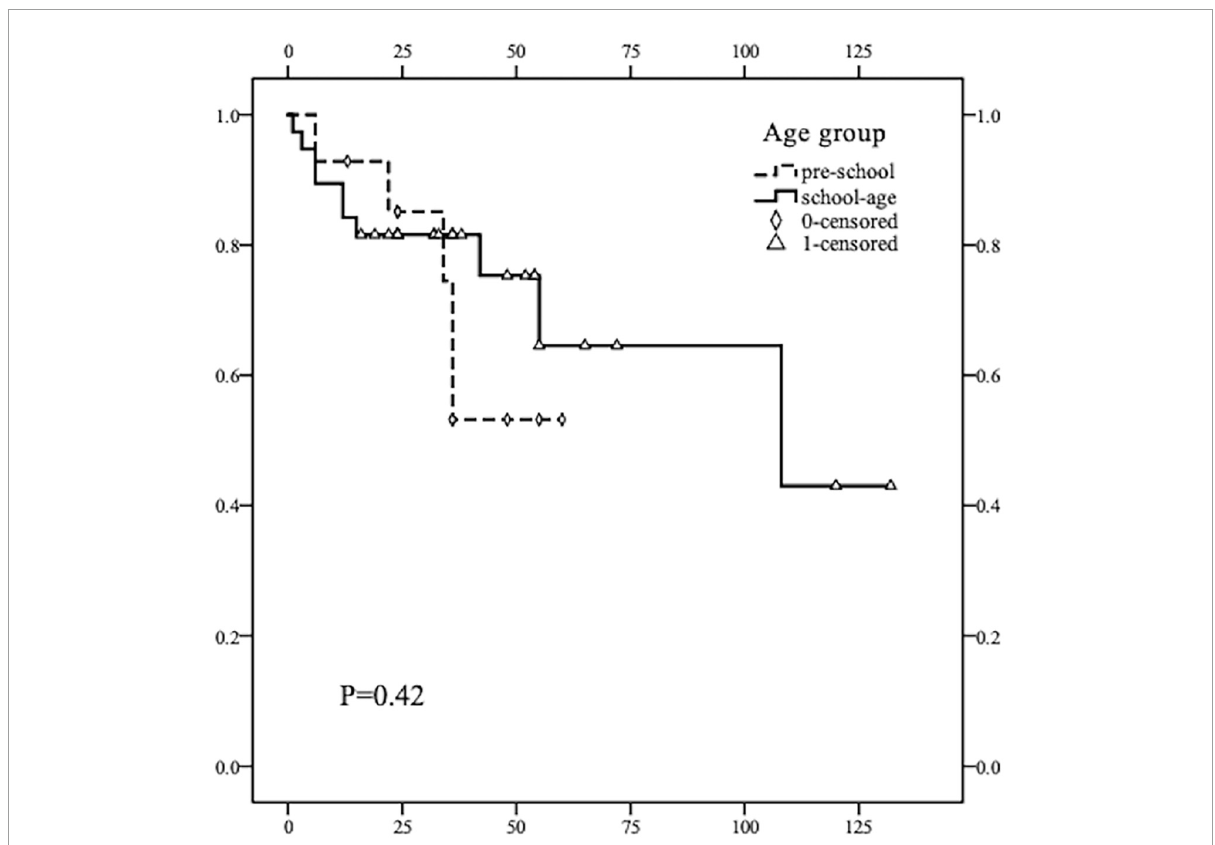
FIGURE1 Kaplan–Meier survival curve comparison of PFS rate in children of different age groups ( ≤ 7 years old and 8–13 years old). The recurrence rate of thyroid cancer in children of the two groups was not statistically significant ( p = 0.42, p > 0.05). The average and median times of recurrence DTC in the pre-school children were earlier than that in the school-age children.